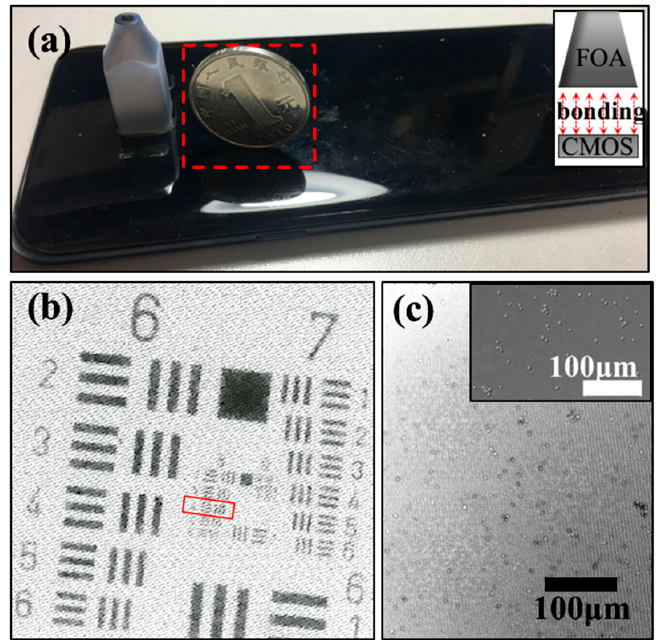
the figure for reference.